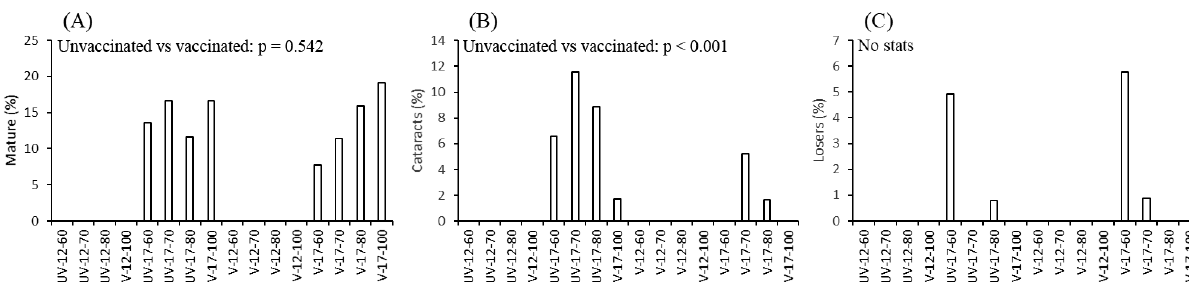
Fig. 3. Percentage of Atlantic salmon that (A) sexually matured as post-smolts, (B) had cataracts, and (C) were ‘losers’. The sta- tistics are from binomial tests of specific parameters. Data are (A) % of males only (n = 34−47 group −1 ) and (B,C) % of the whole population (n = 96−122 group −1 ). Groups on the x -axis are categorised by vaccination status (UV: unvaccinated, V: vaccinated)− temperature (12 or 17°C)−O 2 saturation (60, 70, 80,